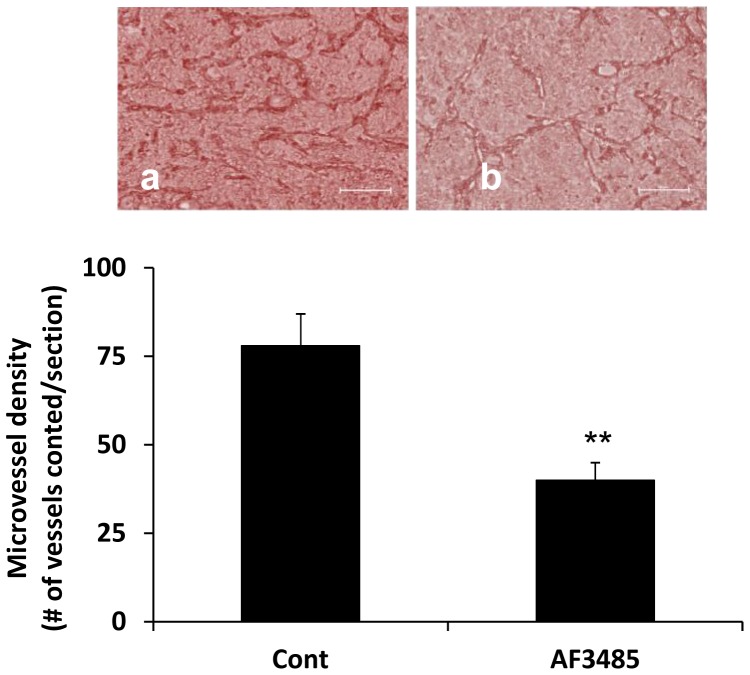
AF3485 inhibits tumor growth and angiogenesis.Representative images of histological analysis of CD31 in tumor sections from (a) control, (b) AF3485-treated mice. Images taken at 40X. Quantification of microvessel density in tumors. **P<0.01 vs Cont.